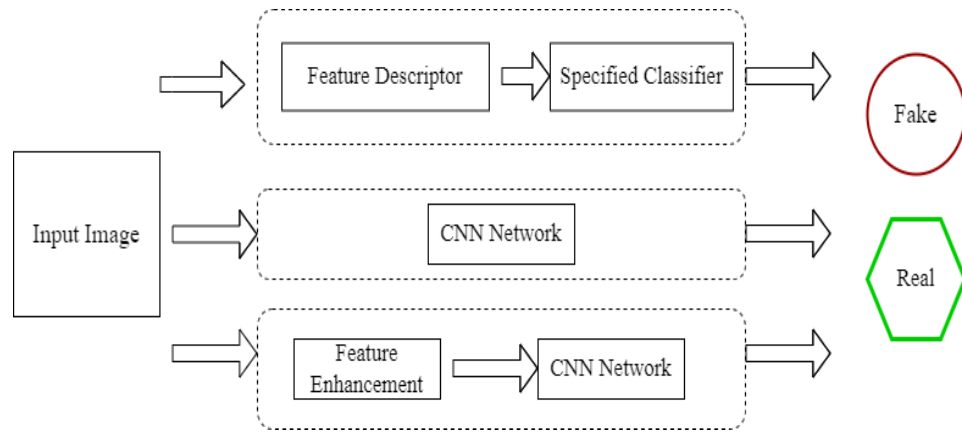
Figure 8. An illustration of CNN architecture used for face liveness detection.